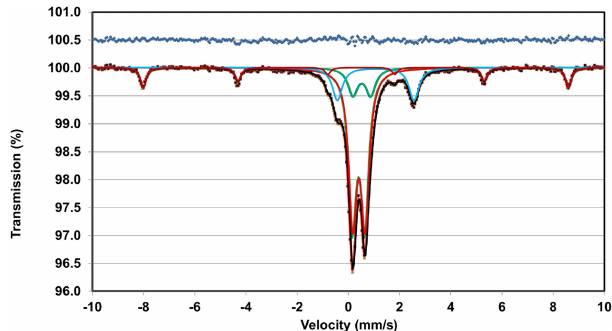
Figure 4. Fitted Mössbauer spectrum for manganrockbridgeite, χ 2 =